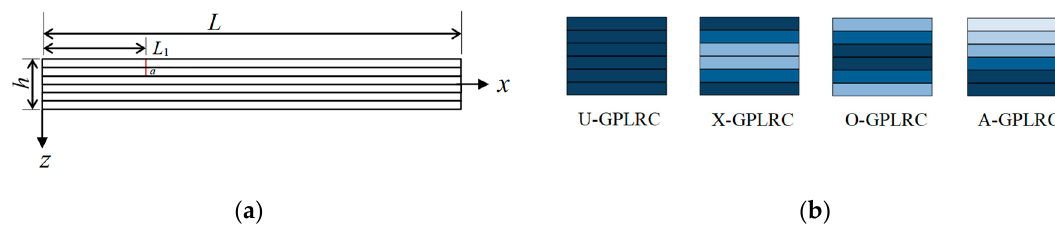
Figure 1. ( a ) Configuration and coordinate system of a graphene nanoplatelets reinforced composite (GPLRC) cracked beam; ( b ) GPL distribution